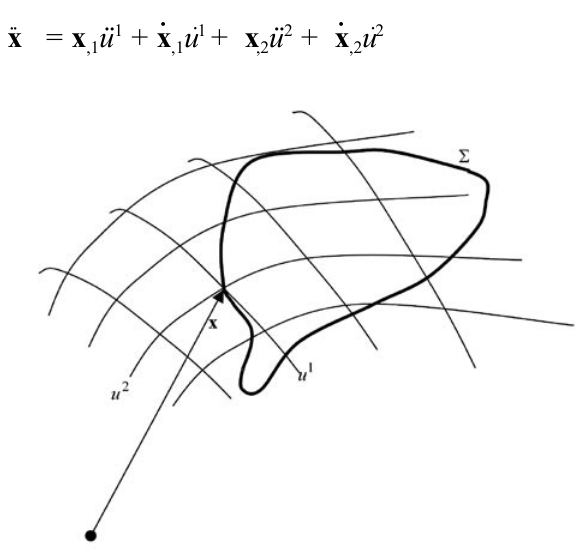
Figure 6 A closed curve on a surface. The portion of the sur- face enclosed by the curve is denoted is given by equation 23.